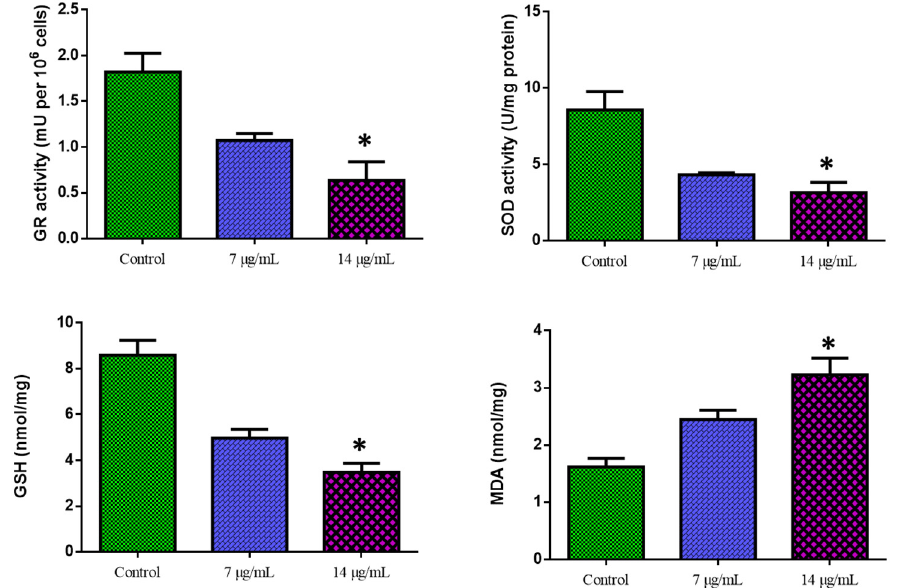
Figure 6. Cuo-TiO 2 -chitosan-escin nanocomposite-induced antioxidant responses in MOLT-4 cells. Using colorimetric analysis, we determined the active levels of GR, SOD, GSH, and MDA in MOLT-4 cell lines after treatment with Cuo-TiO 2 -chitosan-escin nanocomposites for 24 h. The data represented the activities of GR, SOD, GSH, and MDA enzymes and were illustrated as the mean ± SD of triplicates. n = 3, * p < 0.05 compared with control cells.